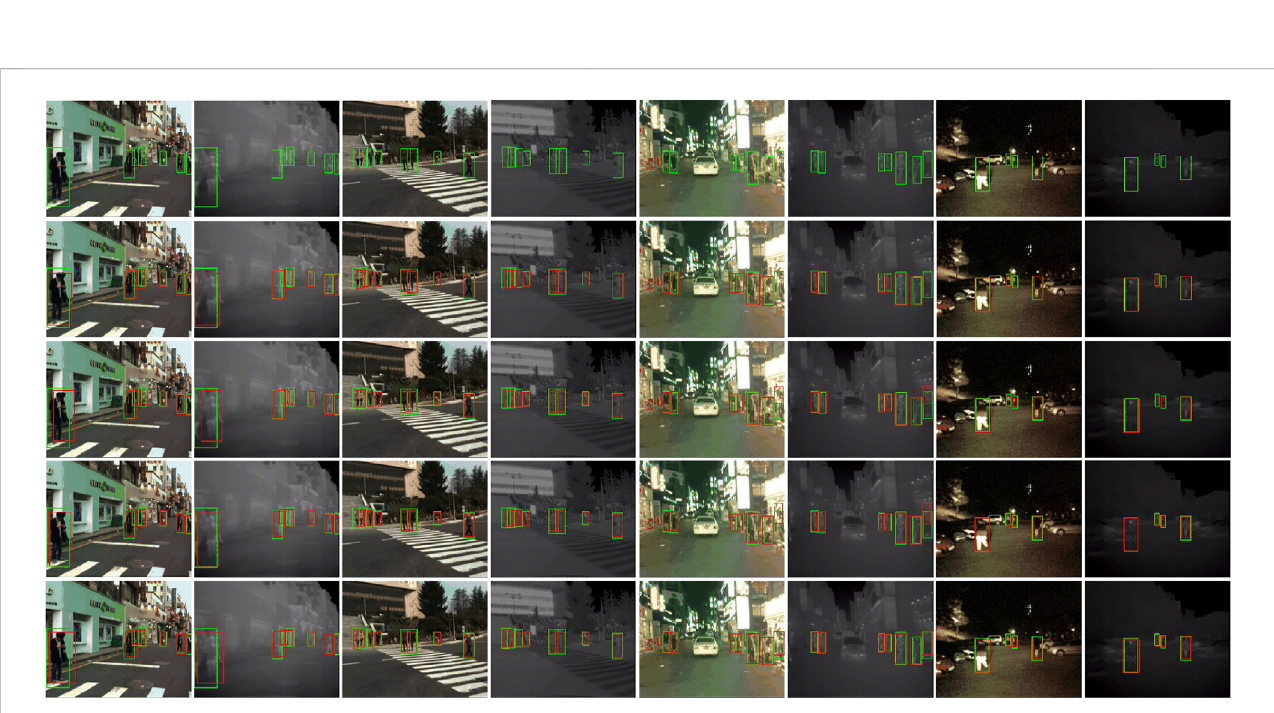
FIGURE 6 In this paper, each module and baseline pedestrian detection results (The fi rst row is the visualization results of labeled boxes for Color and Thermal images, and the second to the fi fth rows are the visualization results of the labeled and prediction boxes for baseline, baseline + CIEM, baseline + CAFFM and the overall model pedestrian detection with the green and red boxes representing the labeled and prediction boxes,